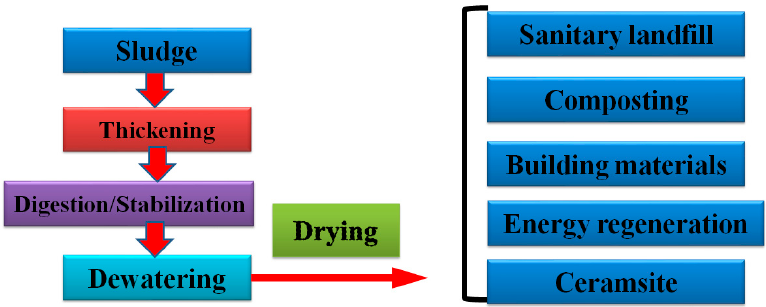
Figure 7. Flow chart of sludge treatment and disposal.